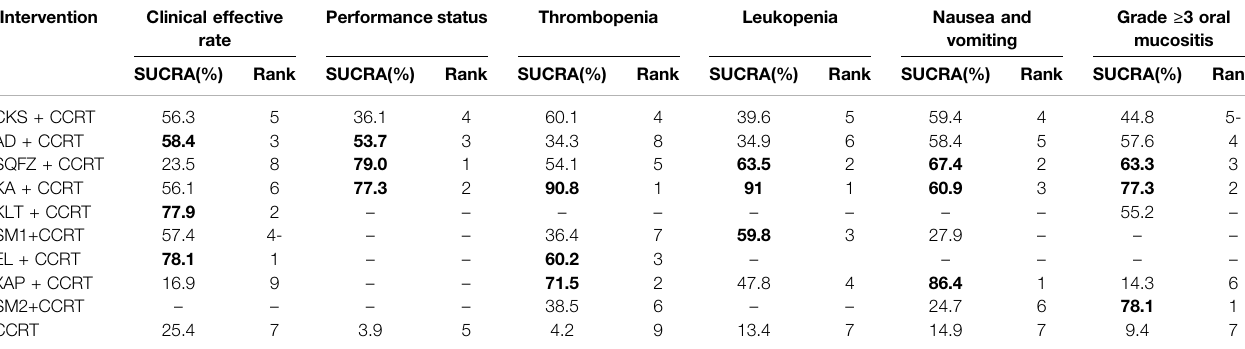
TABLE 3 | Ranking probability of the various interventions among all interventions.